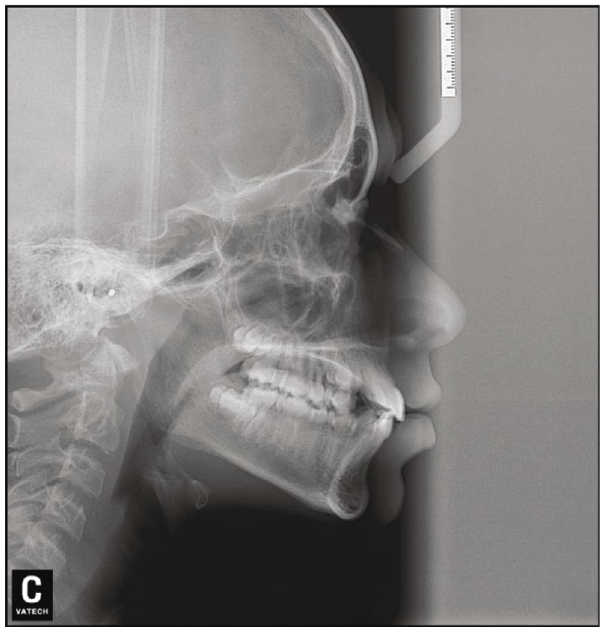
Figure 4: The lateral cephalometric radiograph.